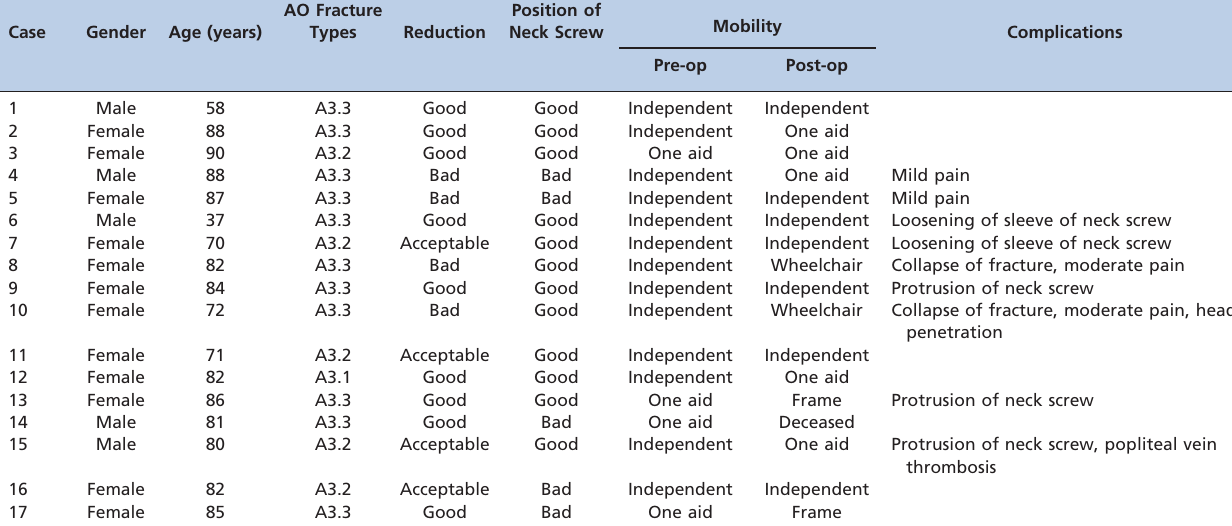
Table 1 - Evaluation of demographic characteristics, radiological results, mobility, and complications.